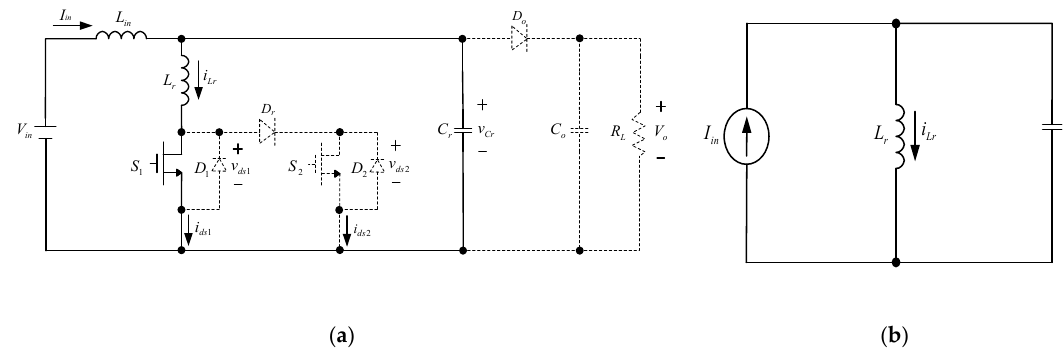
Figure 10. ( a ) Current flow in state 7; ( b ) Equivalent circuit of ( a ).